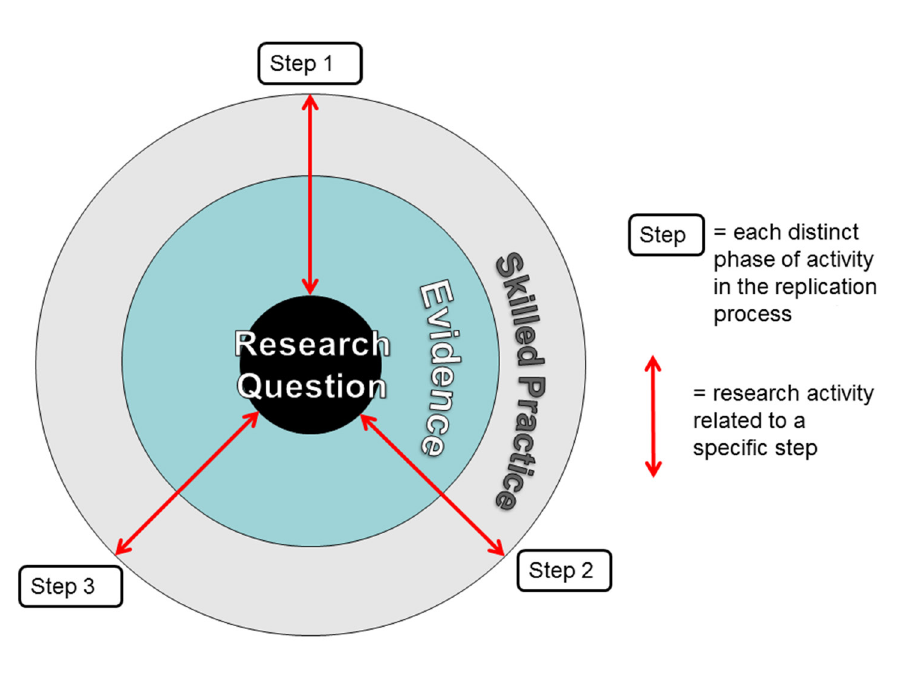
Figure 1. A template of our proposed workflow